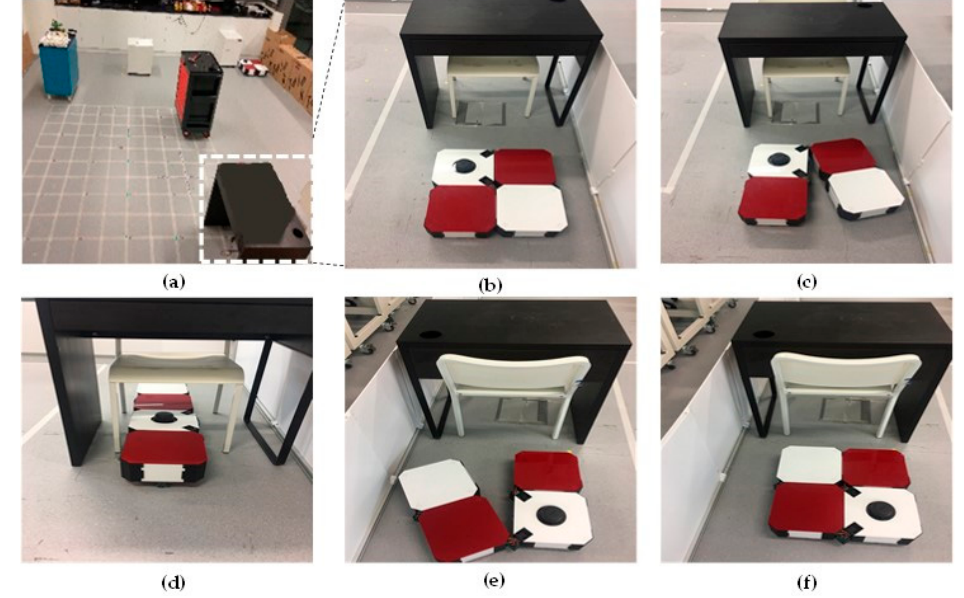
Figure 20. Morphology reconfigurations from O shape to vertical I shape to navigate through the narrow spaces constraints on real environment. ( a ) Detected narrow spaces as red arrows, ( b ) the position before reconfiguring morphology, ( c ) starting morphology reconfiguration, ( d ) navigating with vertical I shape, ( e ) Morphology reshapes to O after going out of narrow space, ( f ) keep navigating with O shape.